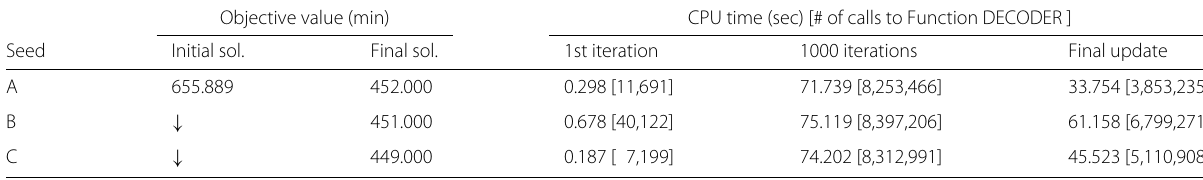
Table 2 Computational